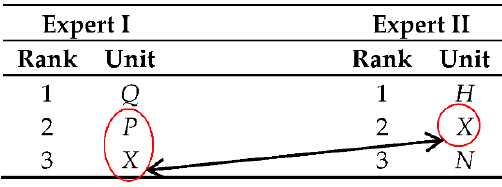
Figure 6. Patch of undefined units.